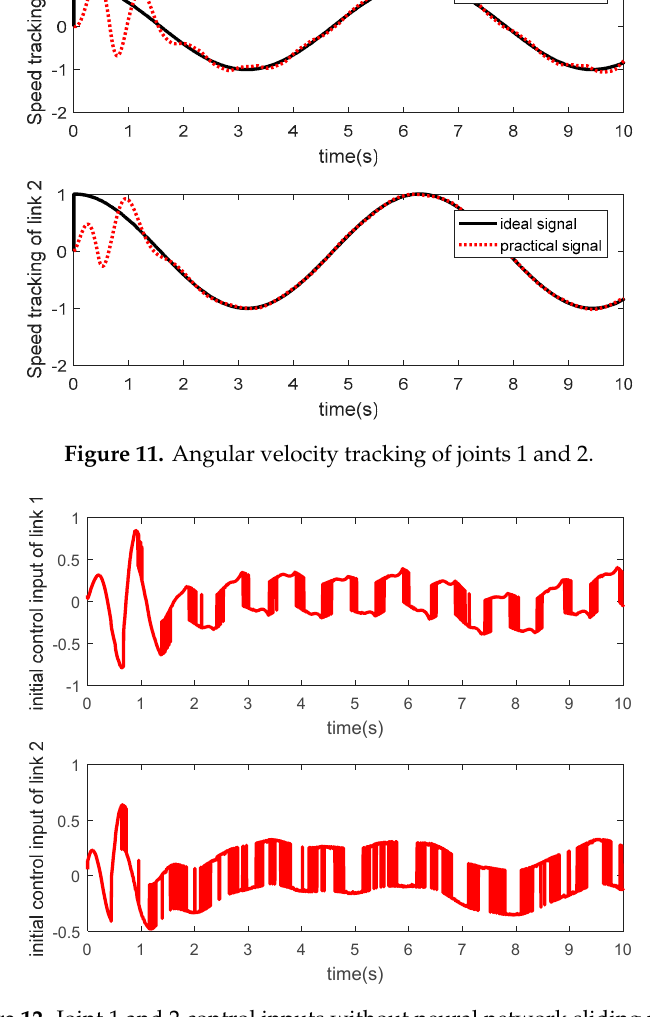
Figure 12. Joint 1 and 2 control inputs without neural network sliding mode.